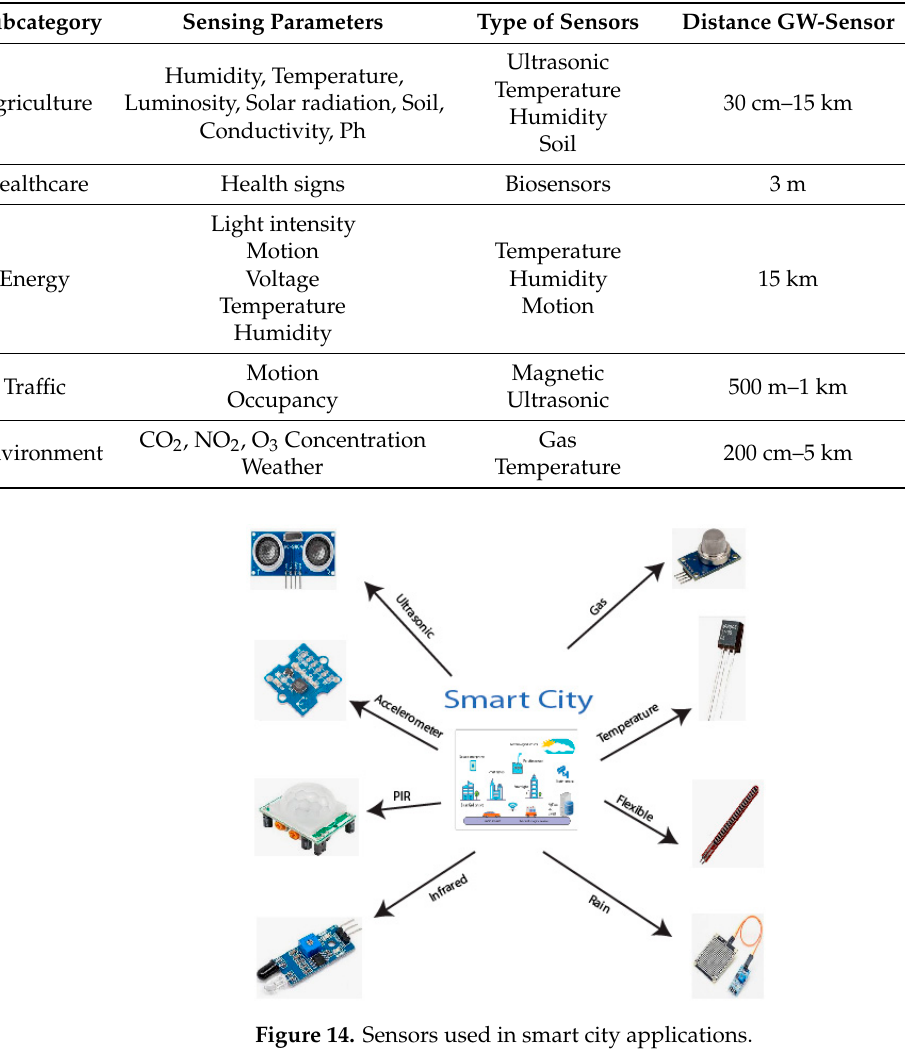
Table 10. Generic specifications of sensors. Subcategory